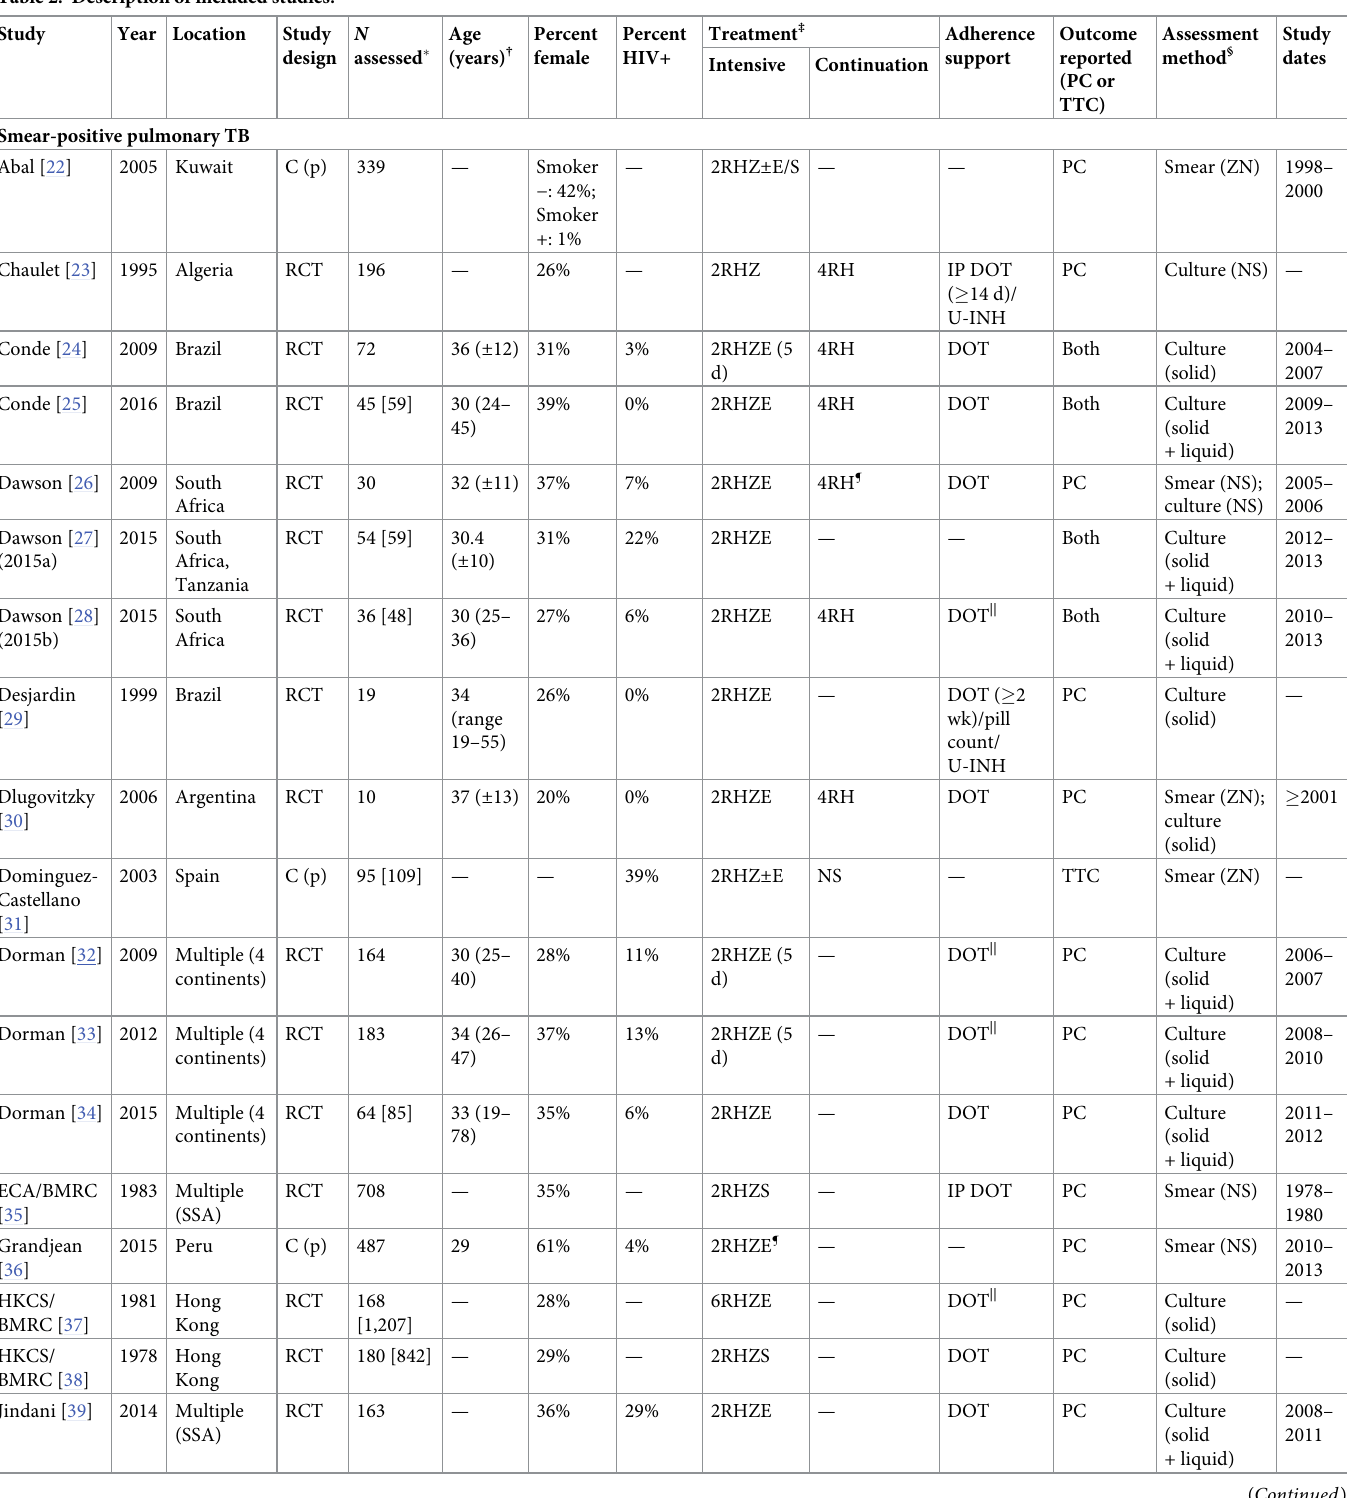
Table 2. Description of included